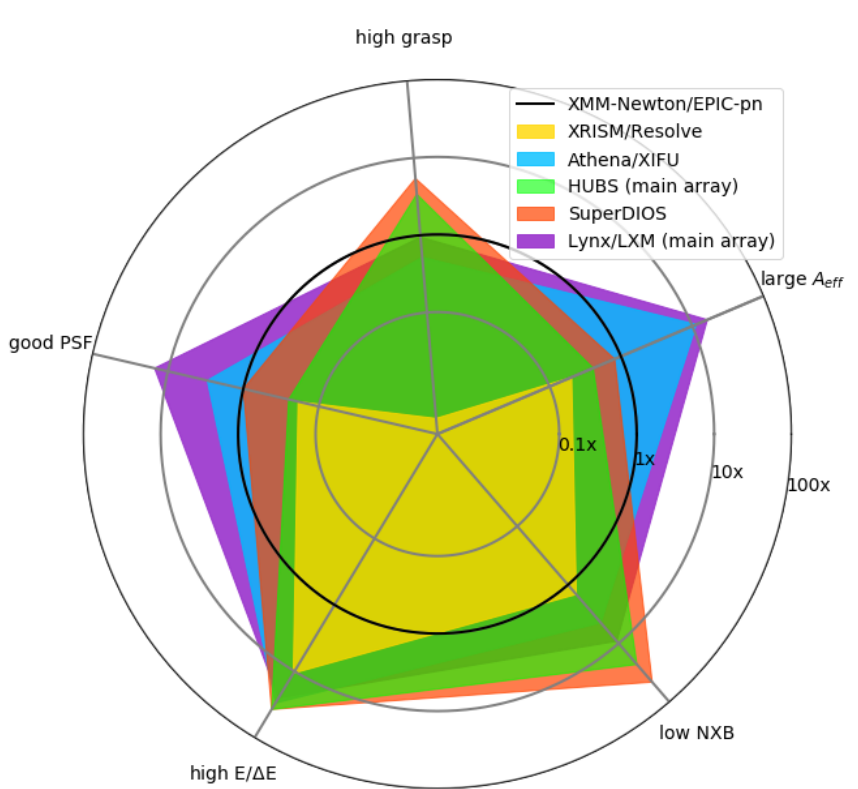
Figure 15. Summary of the capabilities of future missions and mission concepts carrying high- spectral resolution X-ray integral field unit detectors, using the XMM-Newton EPIC/pn as a reference value of 1 along each axis. The grasp is defined as the effective area A ef f integrated over the field of view; plotted along the ’low NXB’ axis are the non-dimensional figures of merit F NXB for detector-background-limited observations (also known as non-X-ray background), expressed as F NXB = A ef f / ( F 2 B ) with F the mirror focal length and B=1 in low-Earth orbit and 4 for high orbits, as defined by, e.g., Reference